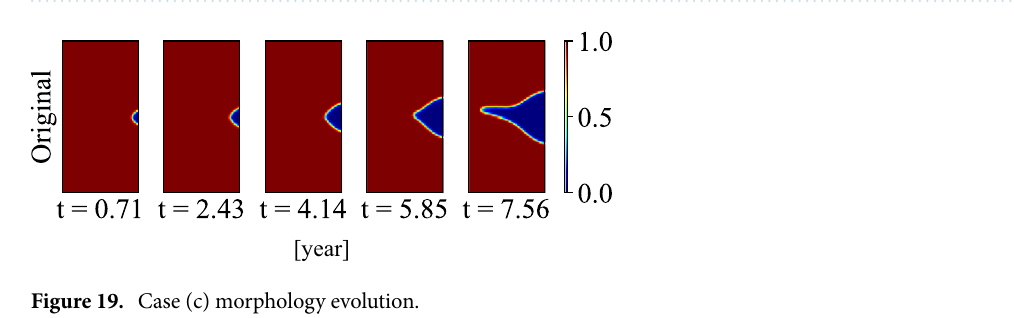
Figure 18. Multiple-step prediction result distribution in the image space.